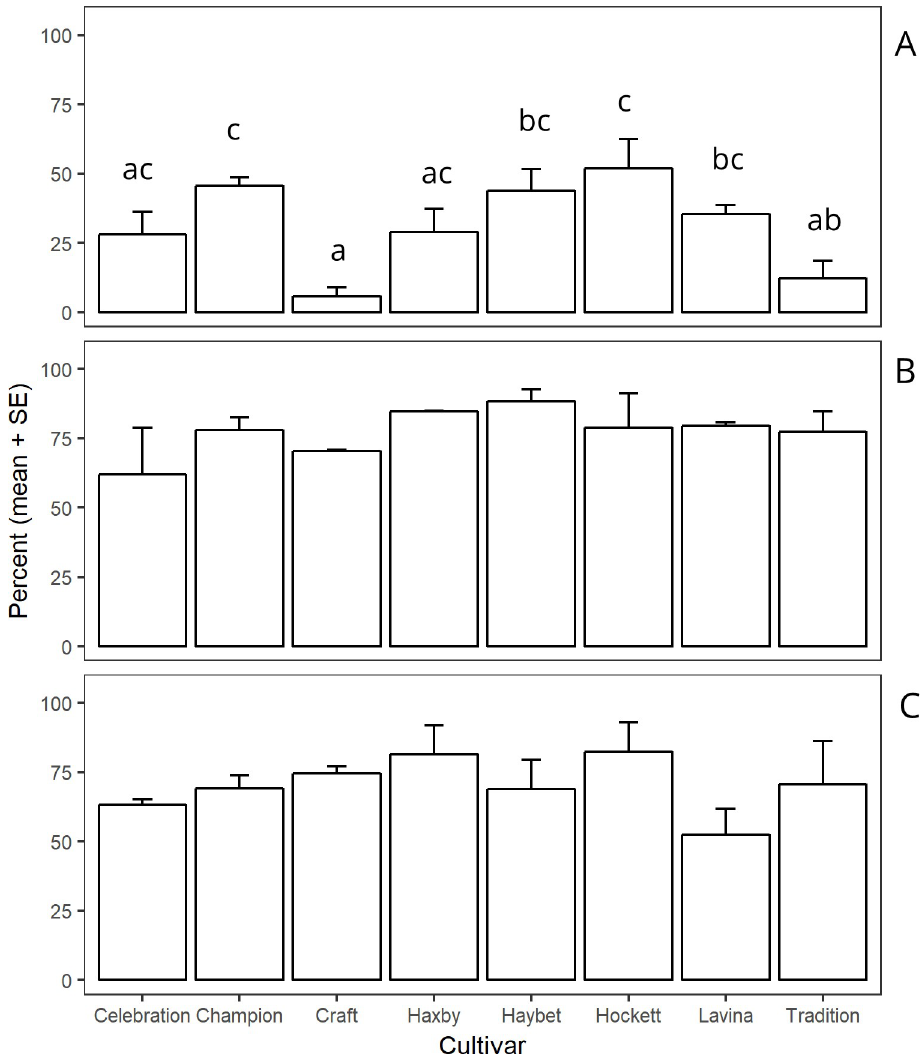
Fig 3. Mean mortality percentages due to cannibalism by site and cultivar. The percentage of mortality was calculated in the presence of other causes of mortality. Bars within the site followed by different letters are significantly different ( α = 0.05) and the bars without letters within the site are not different ( α = 0.05). Panel A: Amsterdam 2016 (F 7, 14 = 6.11, P = 0.002); Panel B: Amsterdam 2017 (F 7, 7 = 0.95, P = 0.523); and Panel C: Big Sandy 2017 (F 7, 14 = 1.008, P = 0.465). SE is standard error of the